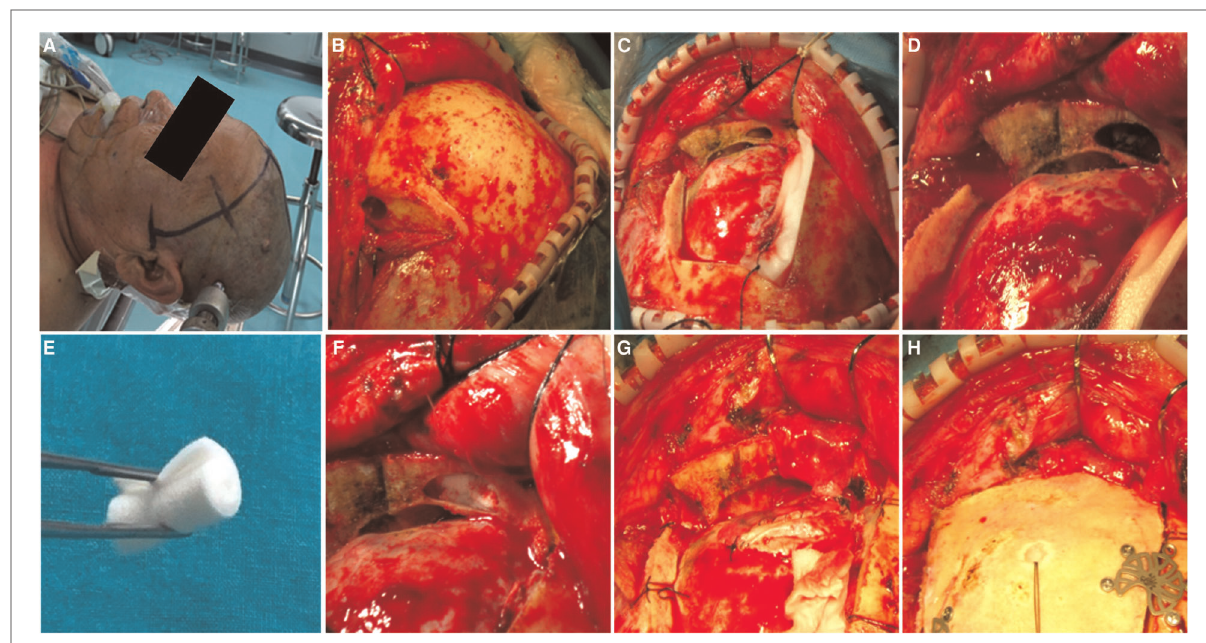
FIGURE 1 The process of frontal sinus reconstruction. ( A ) A coronal skin incision is made in the hairline. ( B ) One burr hole was made at the Key hole. ( C ) The craniotomy was performed in a square shape. ( D ) The open frontal sinus mucosa was peeled off from the inner wall of the frontal sinus and pushed toward to the frontonasal duct. ( E ) Gelfoam was rolled into a cylindrical shape. ( F ) The opened frontal sinus was completely obliterated with gelfoam. ( G ) The vascularized pericranial fl ap covered the roof wall of the frontal sinus. ( H ) The vascularized pericranial fl ap helped to fi x the bone fl ap once it was